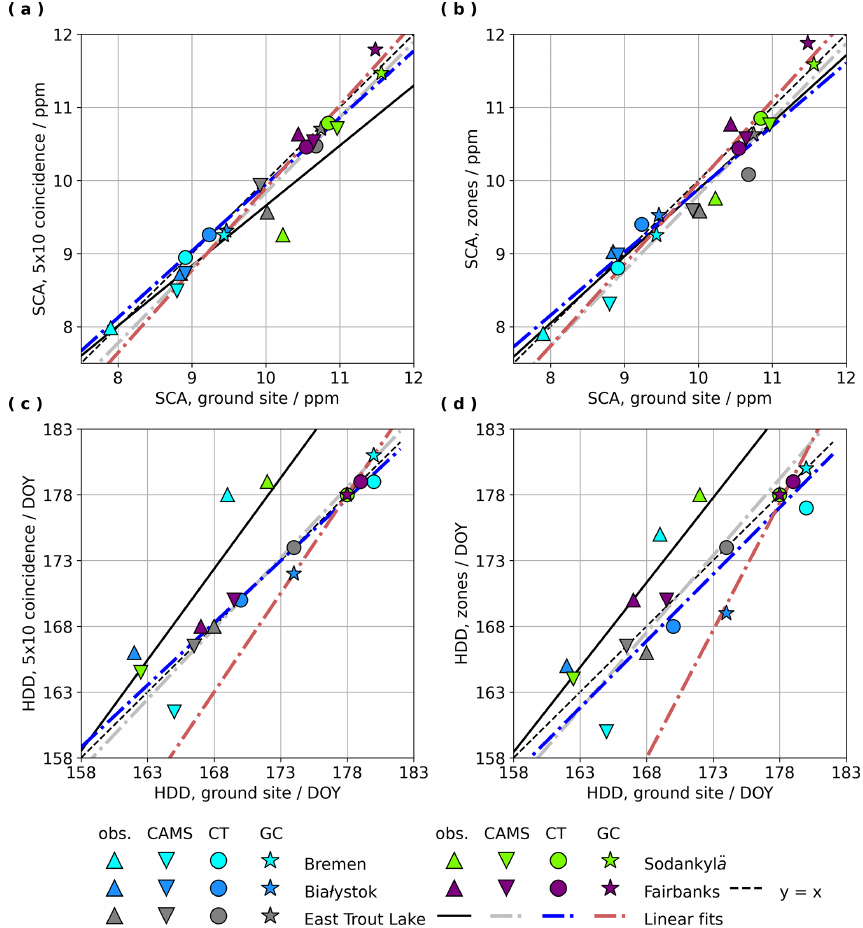
Figure 3. Correlations of SCA and HDD from NNG observations or the model grid point nearest the ground site versus SCA and HDD from spatially averaged OCO-2 observations or model estimates. For these correlations, we only compare across spatial scales by pairing NNG observations with spatially averaged OCO-2 data and pairing single-point CAMS, CT2019B, and GC-CT2019 model estimates nearest to the ground sites with corresponding spatially averaged model estimates in the same model framework. Note that there are some overlapping points in the correlations of HDD in panels (c) and (d) that may visually obscure some of the